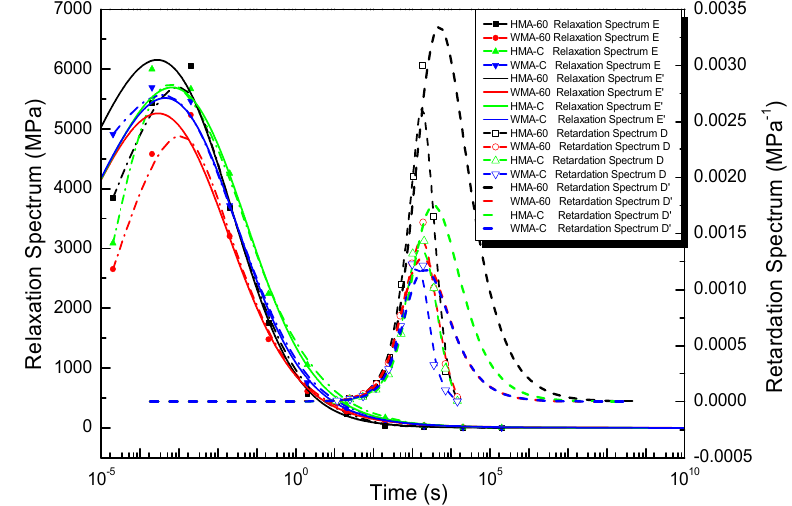
Figure 9. Compared the strength of discrete spectrum obtained from continuous spectrum and Prony series.